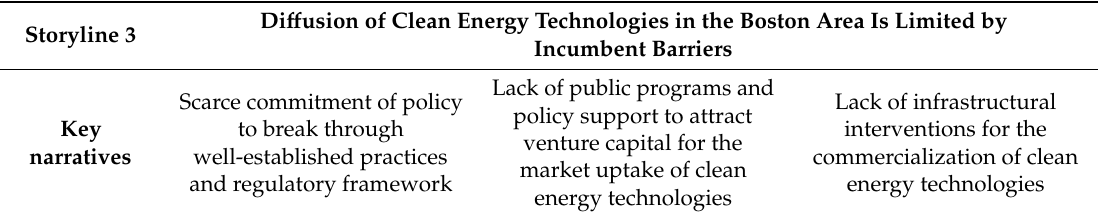
Table 5. Overview of Storyline 3 on delegitimizing public